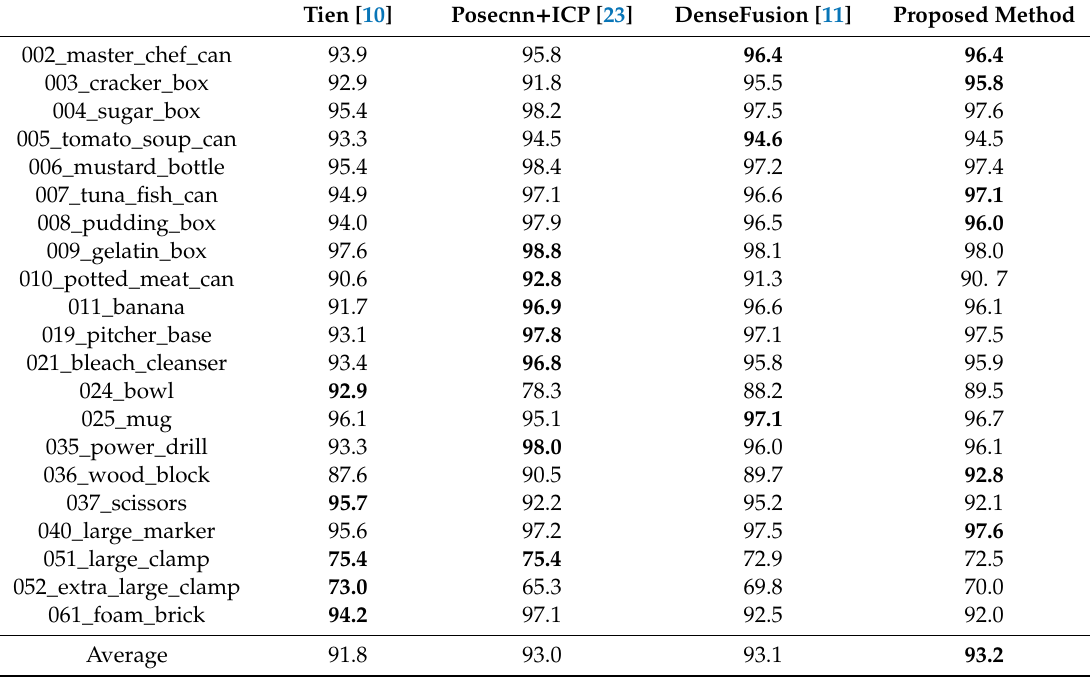
Table 2. Comparison between the proposed method and state-of-the-art approaches on YCB-Video dataset in AUC metric, where the best results are marked in